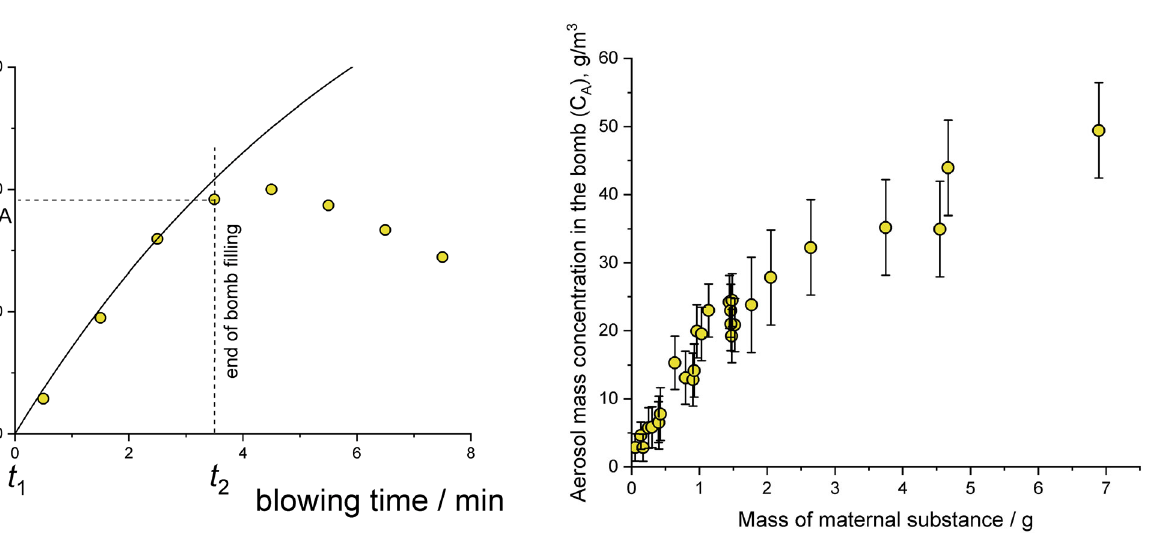
Fig. 12 Aerosol concentration in the bomb versus the mass of maternal substance charged to the aerosol generator